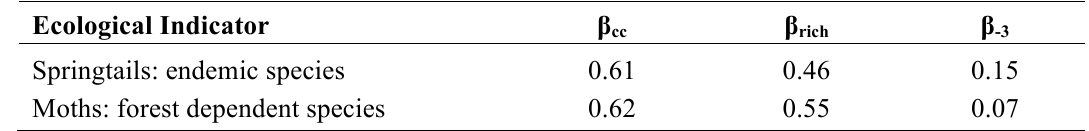
Table 5 . Comparison of β forest-dependent assemblages between sub-natural forest and